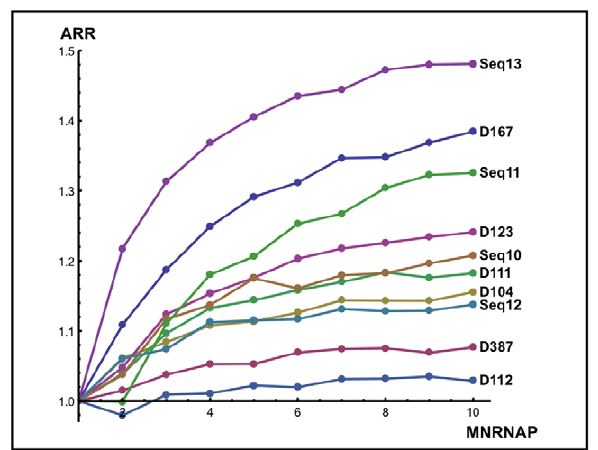
Figure 10. Relative transcription efficiency, E : Each color represents a sequence, as indicated at the end of the respective curve. The E values are shown as a function of the maximum number of enzymes M allowed during the simulation. Note that the asymptotic values of curves are sequence dependent.